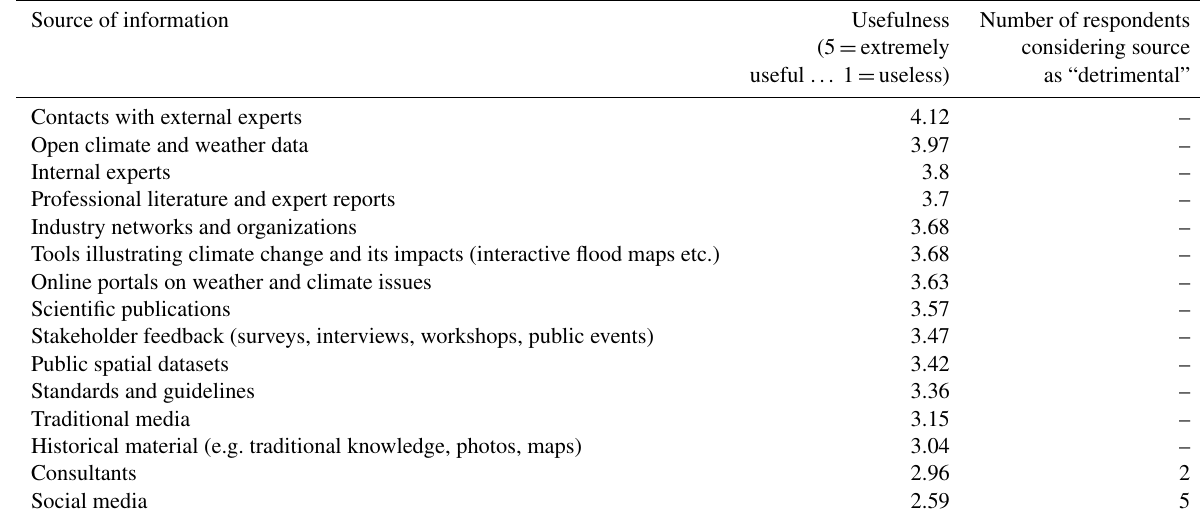
Table 2. The respondents’ views on the usefulness of different information sources in managing weather and climate risks (Appendix A, Question